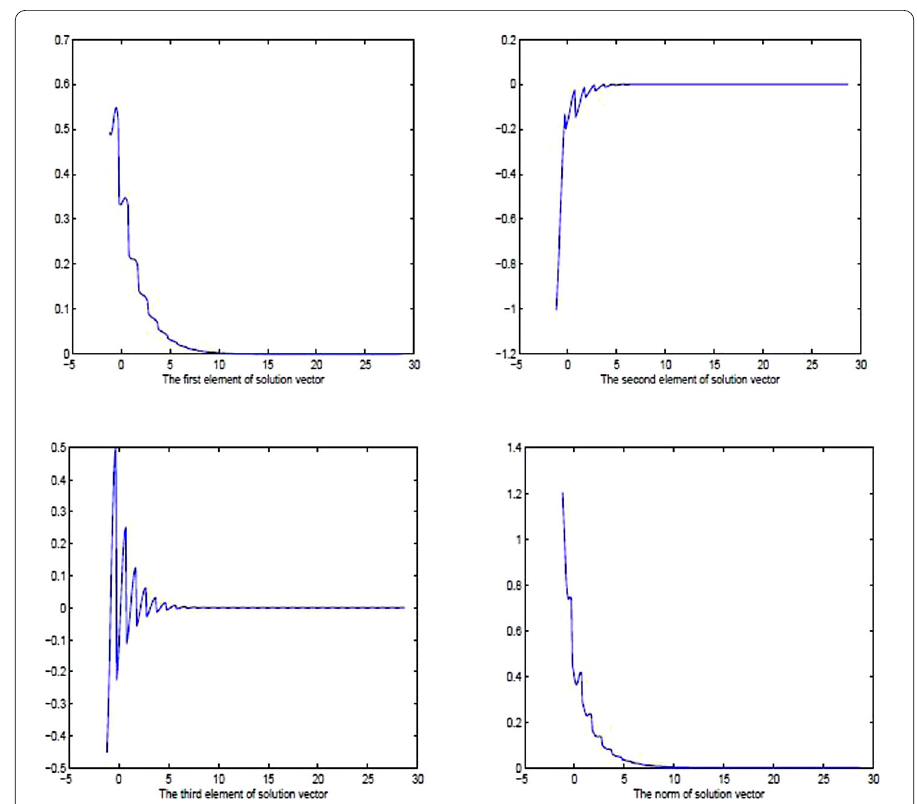
Figure 2 Numerical solutions of three components for Example 1